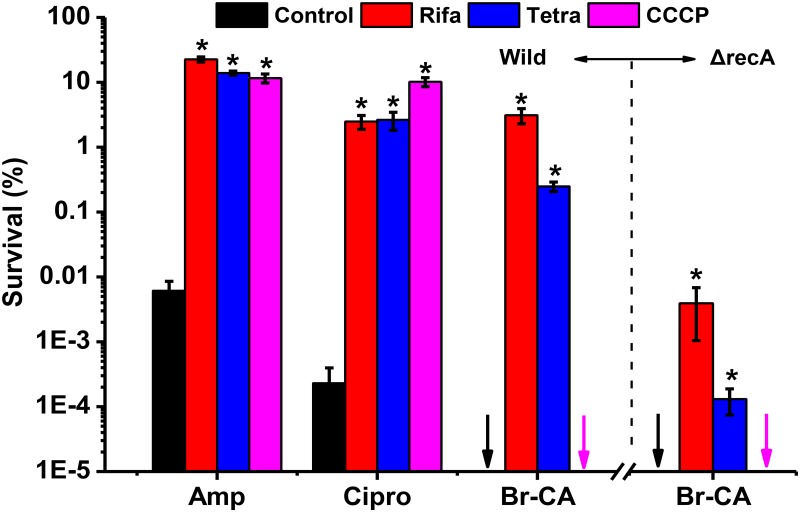
Persister cells induced by chemicals were challenged by Br-CA.Cells were pretreated with Rifa, Tetra or CCCP, respectively except the control group and then exposed to Cipro, Amp and Br-CA for 4 hour. Cell survival percentage after treatment was calculated based on the colony counts on the LB agar plates. The arrows indicated that persister cells were eradicated completely and different colors showed different treatments. Results are means from three independent experiments ± standard deviation. Each bar was indicated as the means of three replicates ± standard deviation. Asterisks indicate a significant difference from their controls (P <0.05).